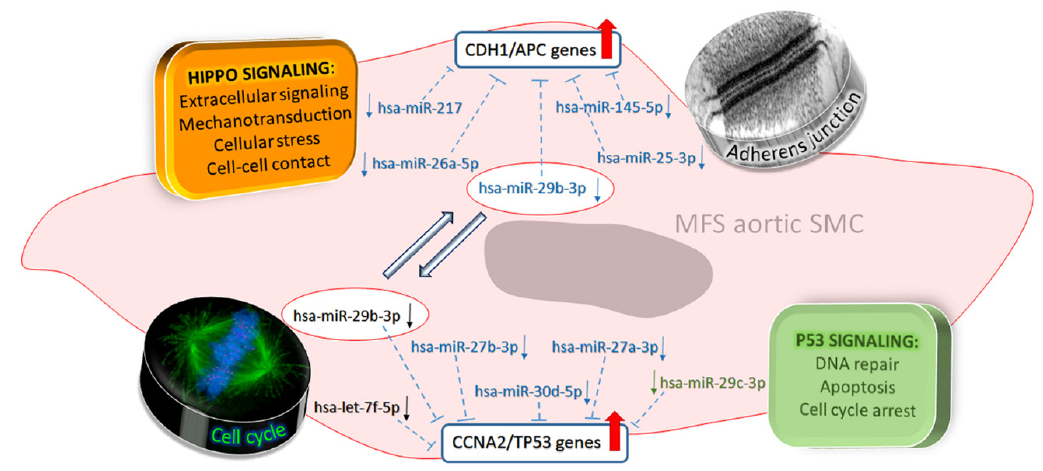
Figure 6. Schematic representation of miRNAs, their related gene targets and cellular pathways likely involved in MFS aortopathy. In blue, miRNAs involved with the Hippo signaling pathway (related to adherens junctions) and TP53 signaling (related to cell cycle); in black, miRNAs belonging to the “cell cycle” pathway; in green, miRNAs belonging to the “P53 signaling” pathway. MiR-26a and miR-217 are involved in Hippo signaling, whereas miR-145 and miR-25 are involved with adherens junction regulation, and their downregulation promotes the activation of CDH1/APC genes, allowing for matrix remodeling. MiR-27b, miR-30d, miR-27a and miR-29c are involved in P53 signaling, whereas let-7f-5p is involved in “cell cycle signaling”, likely through CCNA2 and TP53 upregulation. Downregulation of the miR-29 family induces the expression of collagen types I and III, influencing cardiac fibrosis, which is likely responsible for the compromised aortic distensibility and systemic compliance in MFS patients.